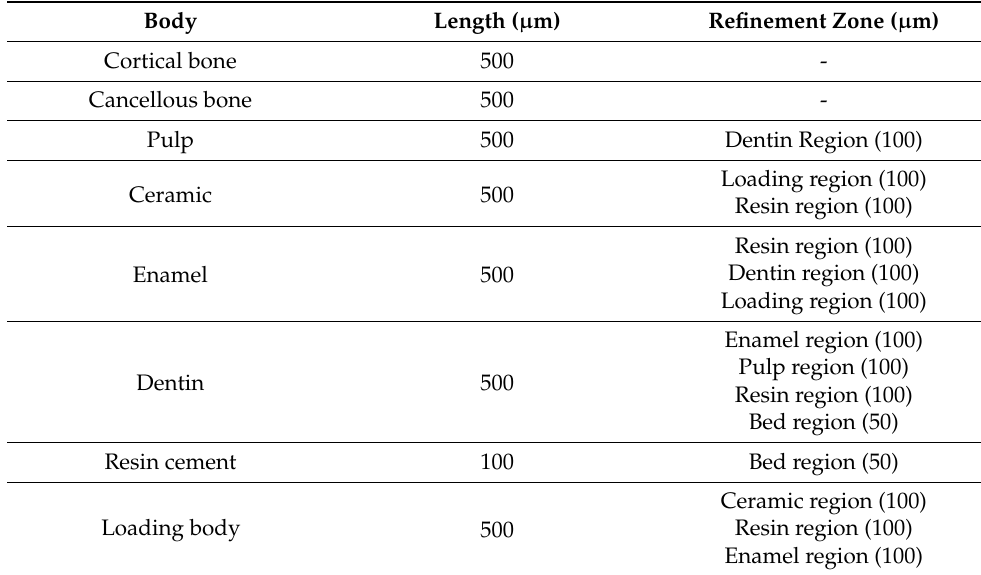
Table 1. Length of the element edges attributed to each component and the refinement zones.